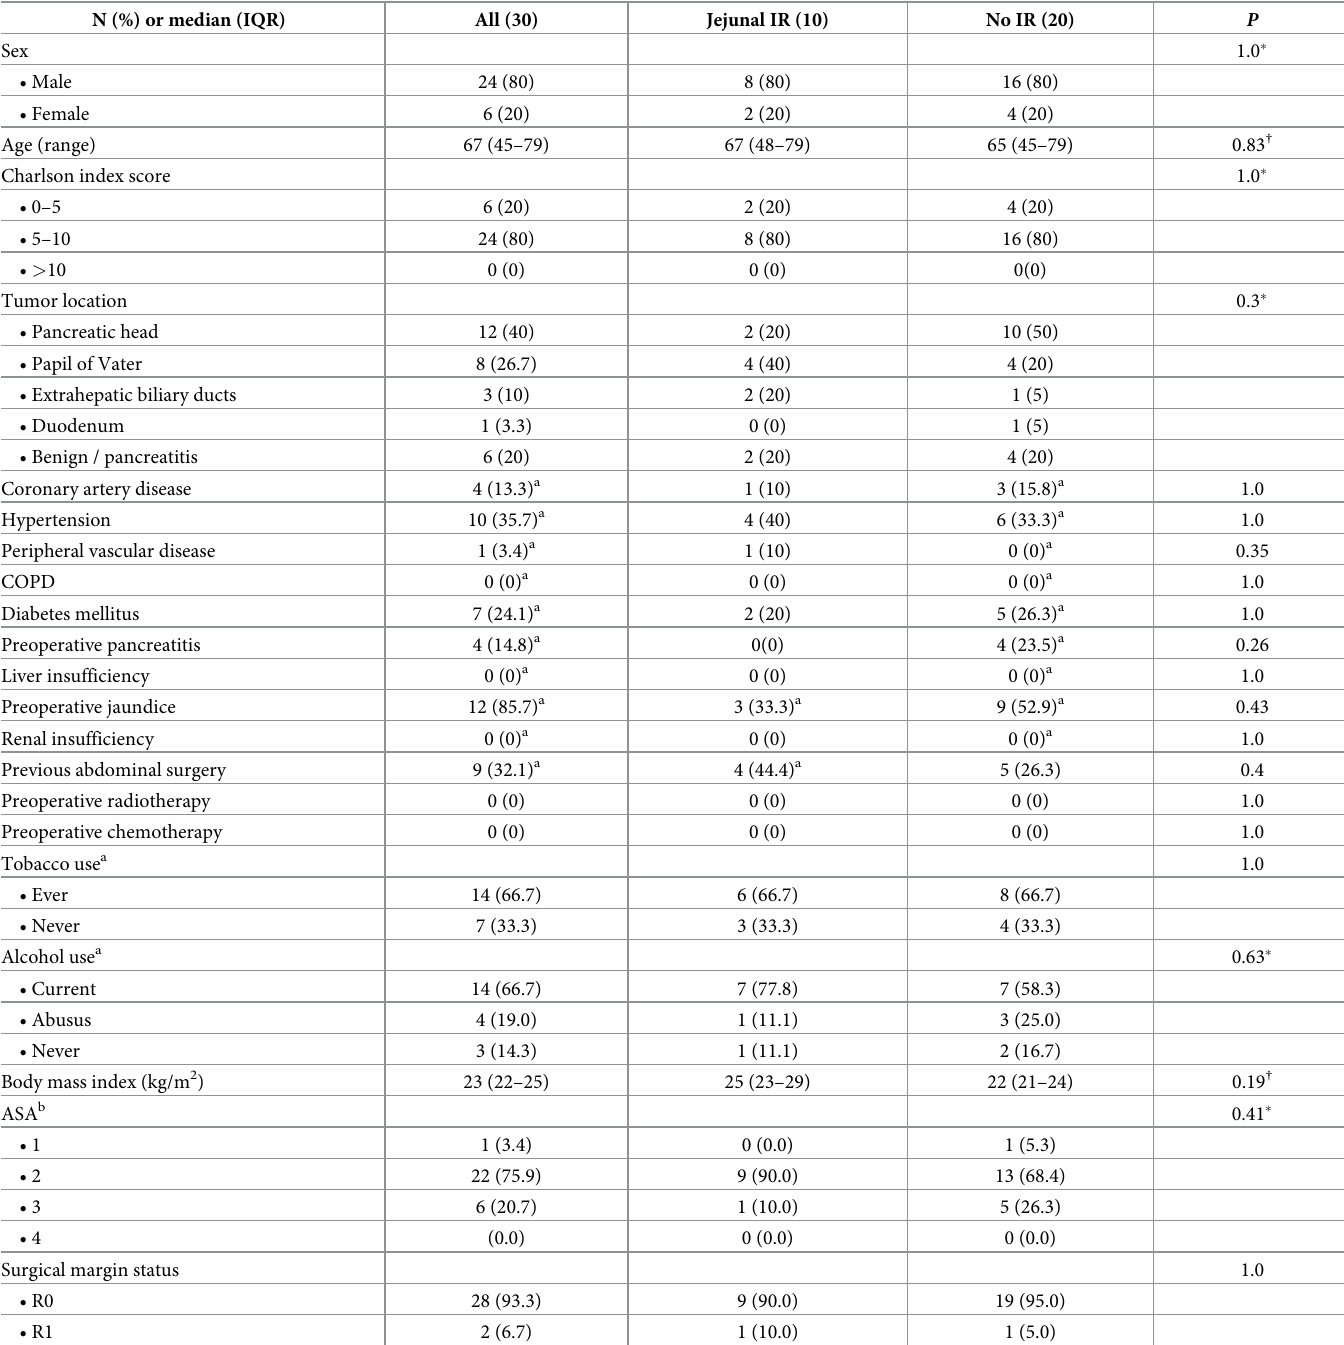
Table 1. Demographics and comorbid conditions of patients undergoing pancreatic surgery with and without experimental in vivo jejunal IR. N (%) or median